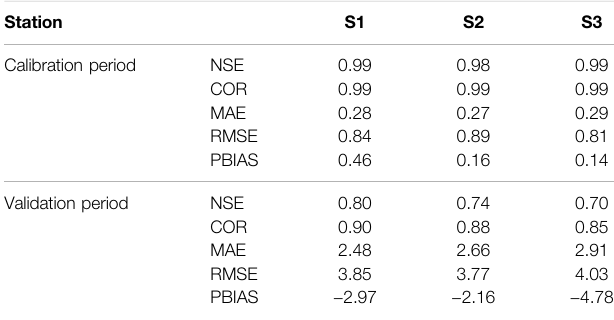
TABLE 3 | Model performance of SCAH in Yangtze River watershed. (Note: Stations S1, S2, and S3 represent Yichang station, Hankou station, and Datong